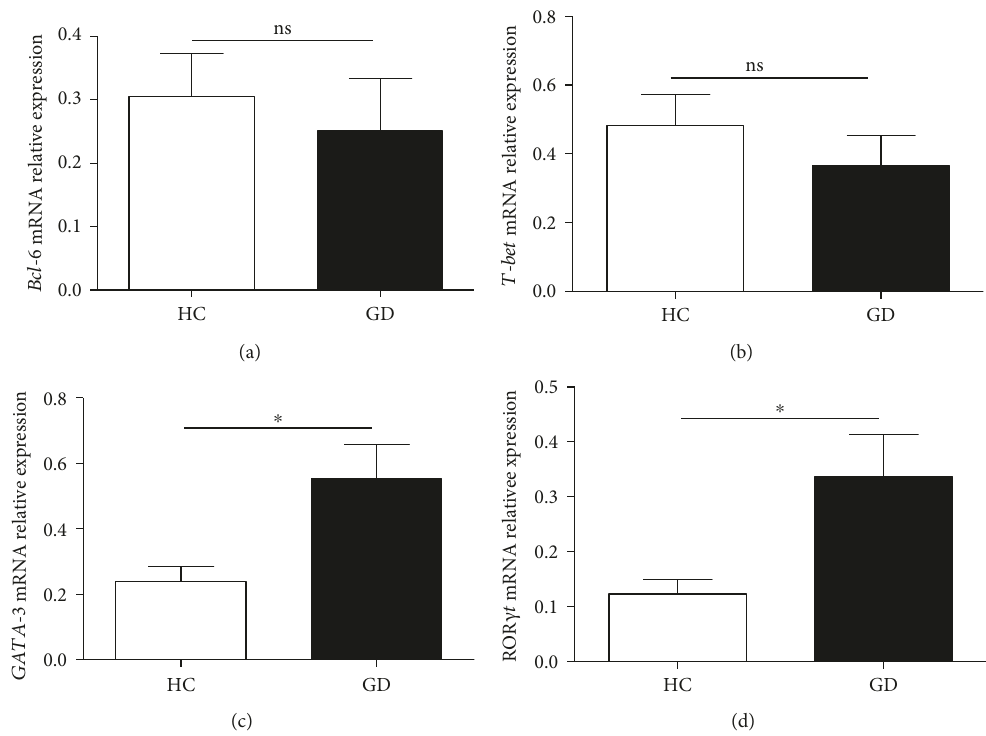
Figure 5: mRNA expression in human CD4 + T cells from GD patients. The expression of several transcription factors (Bcl-6, T-bet, GATA-3, and ROR γ t) in peripheral CD4 + T cells from the 9 GD patients and 12 HC was detected with a real-time PCR assay. (a) Relative expression levels of Bcl-6 mRNA; (b) relative expression levels of T-bet mRNA; (c) relative expression levels of GATA-3 mRNA; (d) relative expression levels of ROR γ t mRNA. ∗ p < 0 05 , ∗∗ p < 0 01 , and ∗∗∗ p < 0 001 ; ns: no signi fi cant di ff